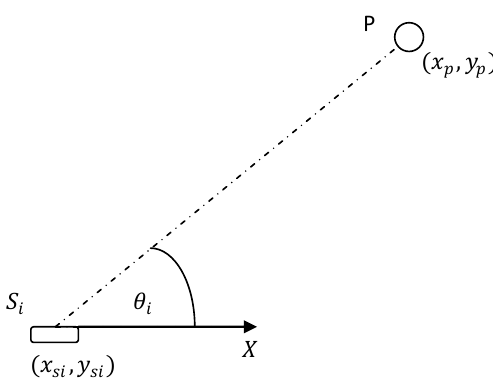
Figure 1. Measurement from a